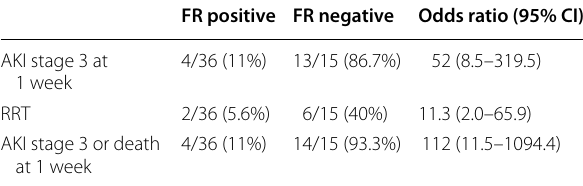
AKI acute kidney injury, FR furosemide